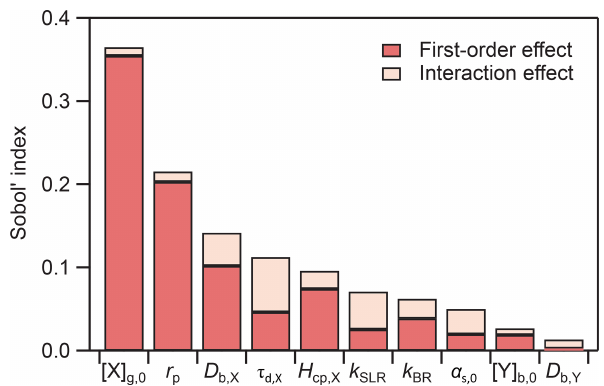
Figure 4. Results of global sensitivity analysis showing Sobol’ sen- sitivity indices for the chemical half-life PCE